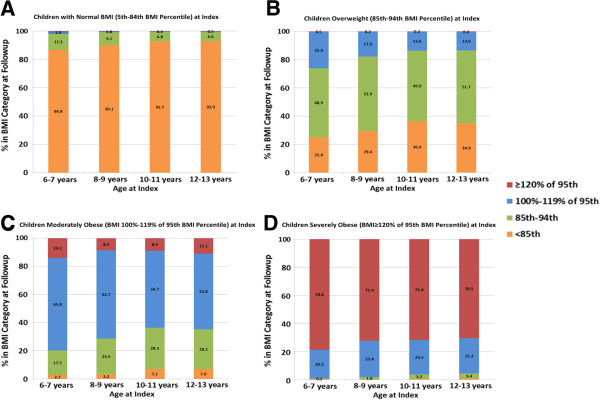
Follow-up BMI category based on BMI percentile and BMI percentage of the 95th percentile by age and BMI at the index visit. (A) For children with normal BMI at the index visit (N = 50,685), an increasing proportion of younger children were overweight at 2–3 years of follow-up (p < 0.001 comparing 6–7 and 8–9 year olds to 12–13 year olds, with no differences between 10–11 and 12–13 year olds, p = 0.6). (B) For children who were overweight at the index visit (N = 14,057), an increasing proportion of younger children were obese at follow-up (p <0.001, test for trend). (C) For children who were moderately obese at the index visit (BMI 100-119% of the 95th percentile, N = 9848), an increasing proportion of younger children were obese at follow-up (p <0.001, test for trend). The proportions of moderately obese children who remained obese at follow-up were significantly different between all age groups (p <0.01) except for 10–11 year olds compared to 12–13 year olds. (D) For children who were severely obese at the index visit (N = 4295), nearly all were obese or severely obese at follow-up (95.7-99.3%). Children in the youngest age group (6–7 years old) had the highest prevalence of severe obesity at follow-up compared to other age groups (p <0.05). Differences between the older age groups were not significantly different.